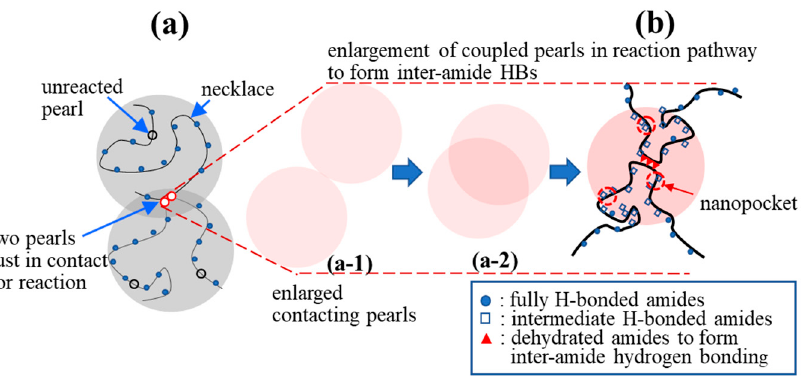
Figure 10. Proposed formation of a physical junction: ( a ) Two a-PNIPAM chains are connected via the hydrophobic interaction of the “pearls” in the overlapping region (red circles, reacted) to form “coupled pearls”; the hydrophilic necklaces contain the fully H-bonded amide groups with 3 bound water molecules, while the hydrophobic pearls contain the dehydrated amide groups with less than 3 bound water molecules; ( b ) enlargement of the “coupled pearls” to illustrate the collapsed chain segments to highlight the interchain association via inter-amide hydrogen bonding. (a-1) and (a-2) show the reaction pathway of the two contacting pearls that gradually overlap and eventually develop the inter-amide HBs in ( b ).